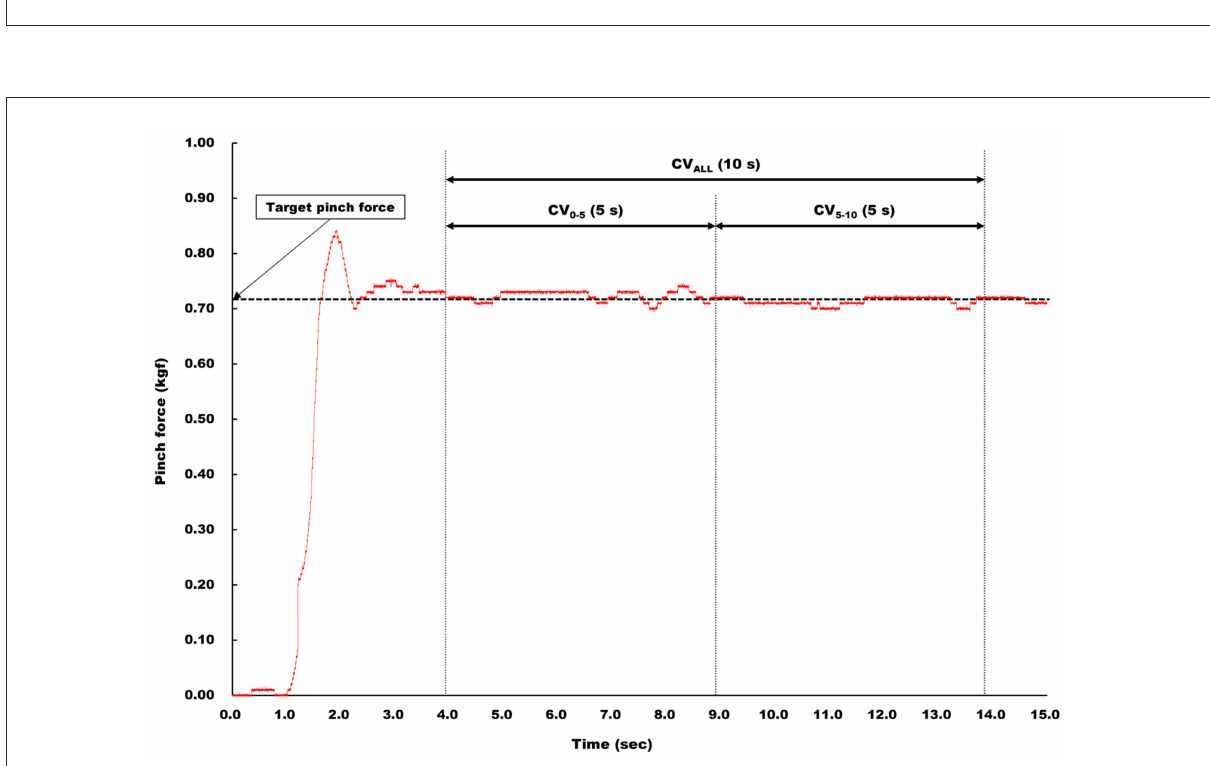
FIGURE1 Experimental protocol. This figure shows experimental protocol in the present study. For each Pinch task, pinch force value and EMG activity were simultaneously recorded during precision pinch grip at 10% maximal pinch grip force. Subjects under the pleasant image condition viewed a pleasant picture of “Puppies”, while subjects under the neutral image condition viewed a neutral picture of “Mugs”.